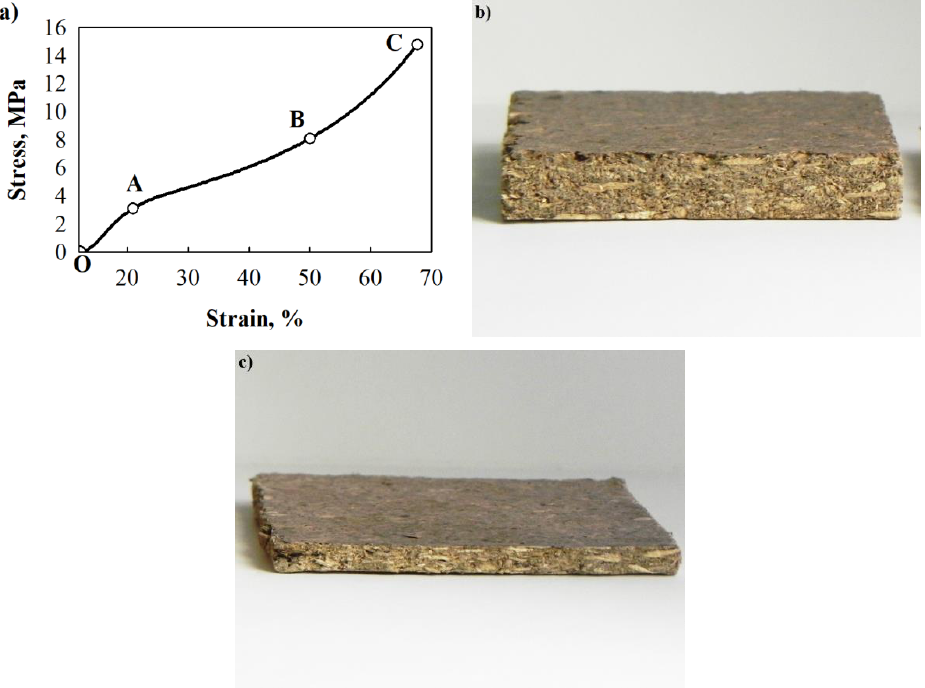
Figure 2. Peculiarities of short-term compression of BcB: ( a ) compression curve “stress–deformation”; ( b ) non-compressed BcB 50 × 50 × 10 mm 3 ; ( c ) up to 70% relative deformation compressed BcB 50 × 50 × 3 mm 3 .